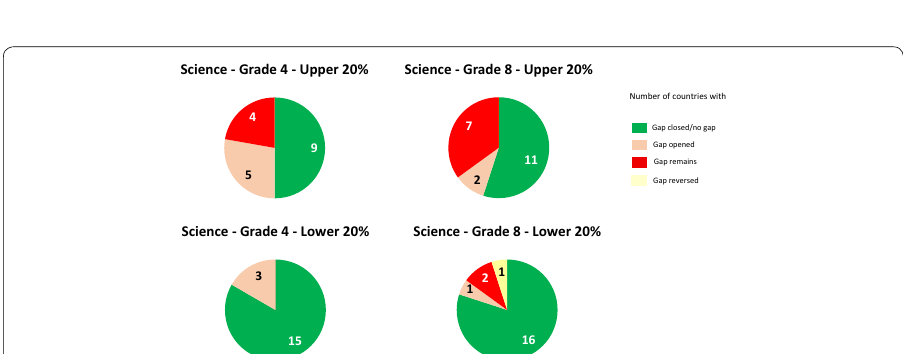
Fig. 5 Changes in gender gaps in science achievement in grades four and eight in the group of the 20% highest achieving and the group of 20% lowest achieving students between 1995 and 2015. Example description of upper left pie chart (grade 4, upper 20% of distribution of math achievement): In four countries, a gender gap remained; In five countries, a gender gap opened, i.e., developed where there was none before; In nine countries, the gender gap closed or there is none in 2015 and there has not been a gap in 1995